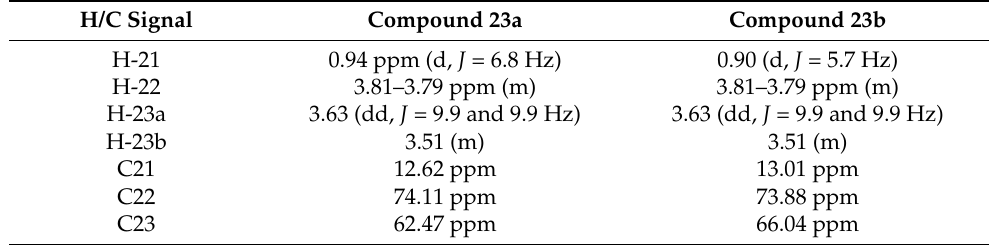
Table 1. Comparison between signals of 1 H (400.1 MHz, CDCl 3 ) and 13 C (100.6 MHz, CDCl 3 ) NMR for H/C21, H/C22 and H/C23a-b, for the diasteroisomers 23a and 23b